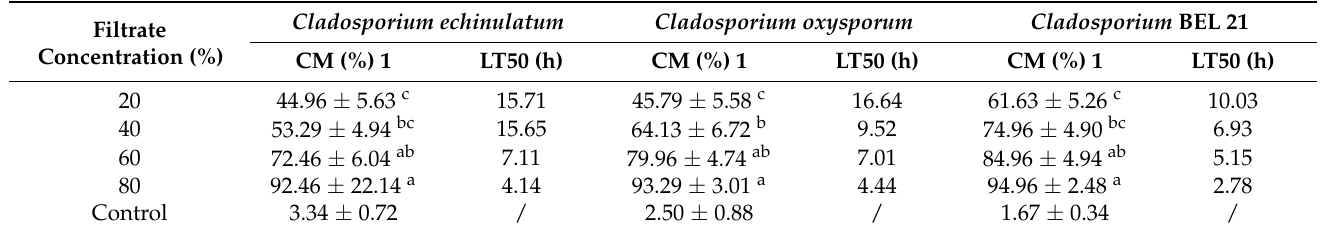
Table 1. Aphicid activity and LT50 of the designed bioformulations against M. persicae .